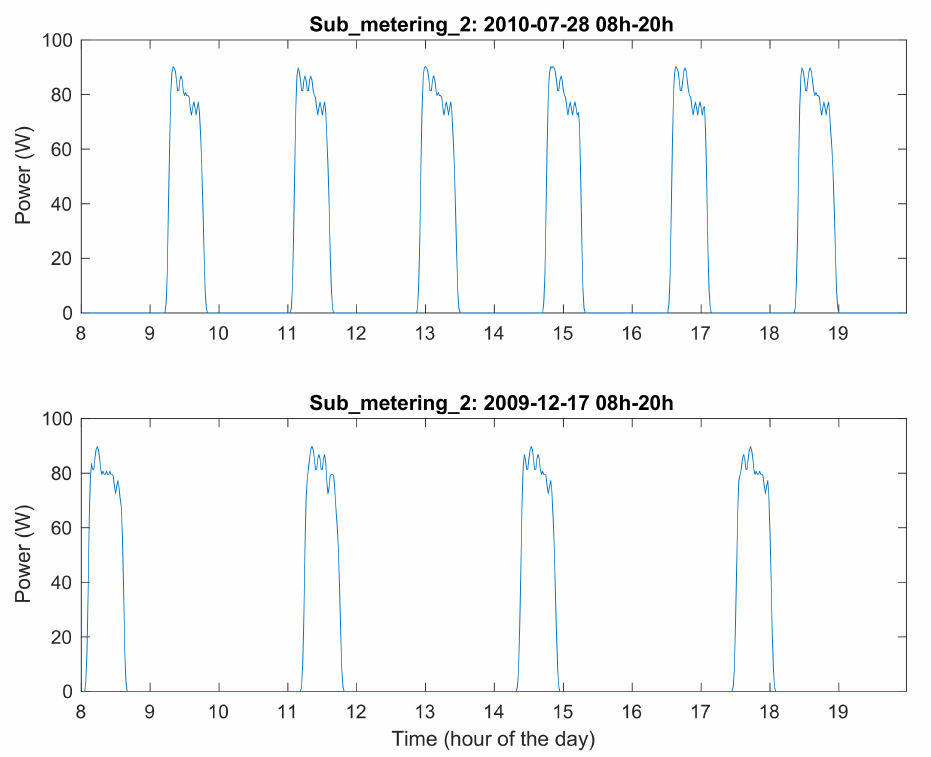
Figure 9. Profiles of the refrigerator in summer and